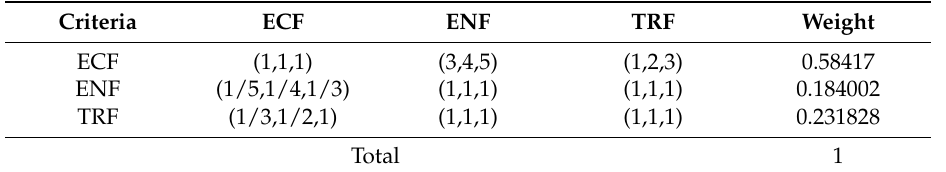
Table A3. Comparison matrix for SOF.